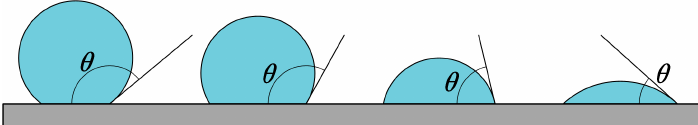
Figure 6. Droplet contact shape and contact angle.